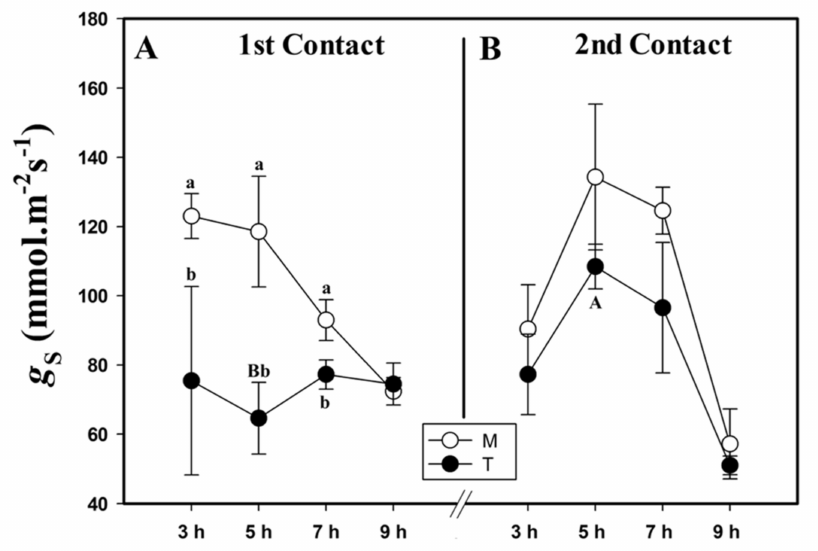
Figure 2. Stomatal conductance ( g S , mmol.m − 2 s − 1 ) of the first ( A ) and second ( B ) contact with MeJa (treated (T)) and mock (M) groups. MeJa was applied to the first fully expanded leaf of the plants of the T group at 6:00 am, 0 h after application (HAA), and evaluations were made at 3, 5, 7, and 9 HAA. The results are from a one-way ANOVA repeated measures, followed by Tukey’s test with a significance level of 5% ( p < 0.05). The data refer to means ( n = 4), error lines indicate standard deviation. Lowercase letters indicate differences between the T and M groups in the respective contact, while uppercase letters indicate differences between the first and second contact in the T group ( p <